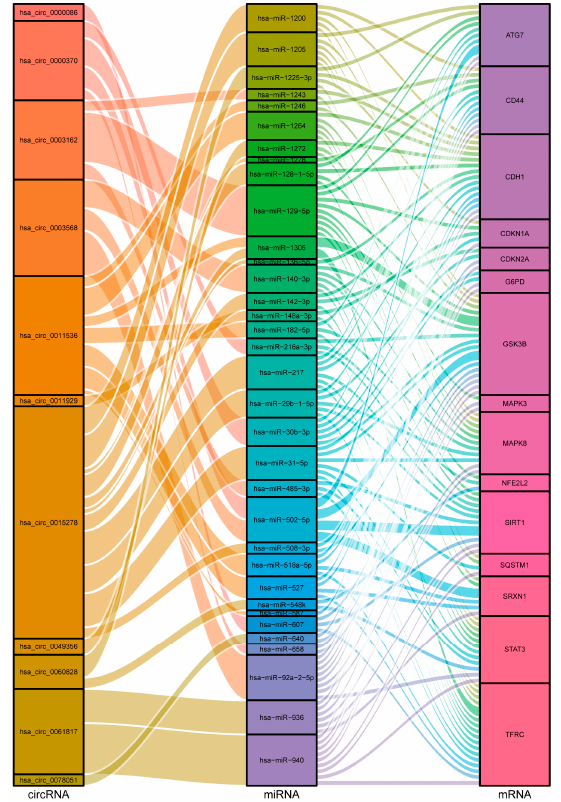
Figure 3. Sankey diagram presents the ceRNA network involving 15 hub genes. The area of the squares in the Sankey diagram represents the data content. Columns represent the molecular category, and different squares represent different molecules. The thickness of the lines represents the degree of closeness between the molecules.